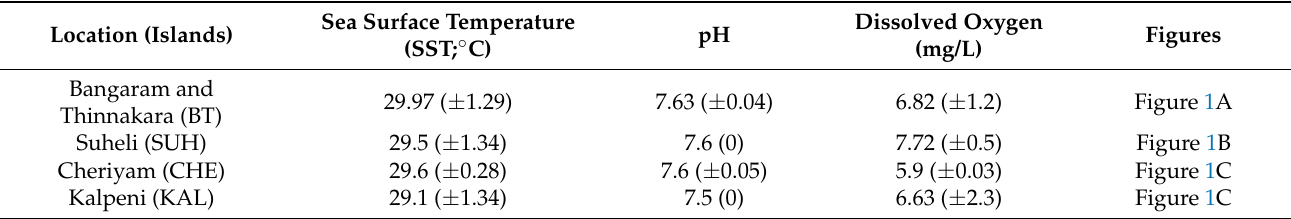
Table 1. Environmental parameters recorded at each surveyed site (November